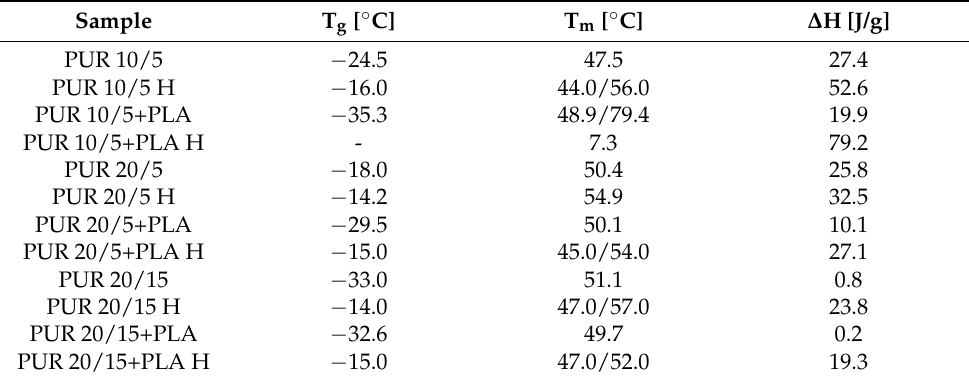
Table 6. Thermal properties of PURs and their blends with PLA before and after incubation in the buffer